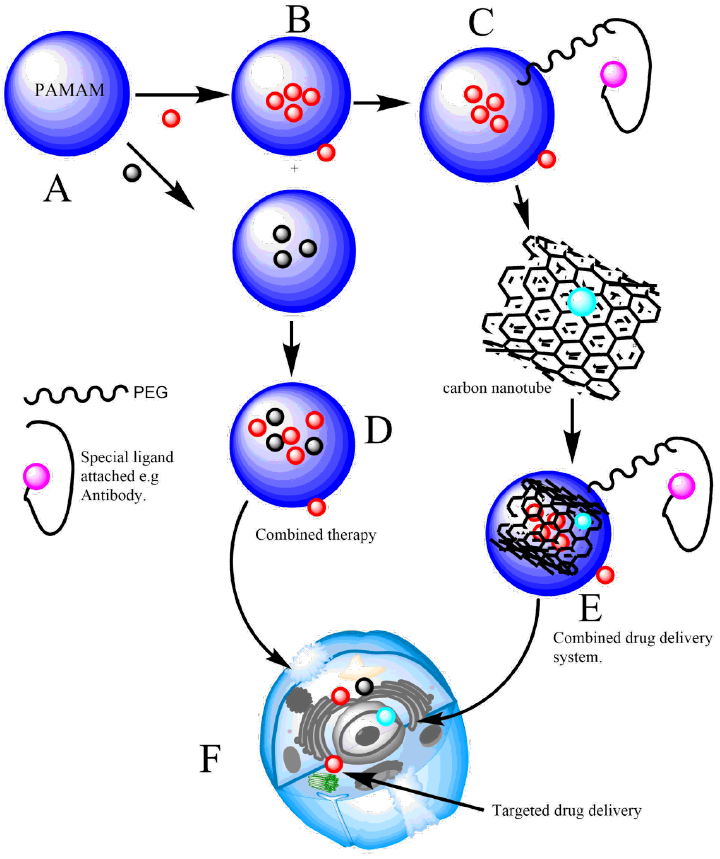
Figure 1. A scheme representing two systems which is promising in improving the solubility of poorly water soluble molecules. B , D show a combined therapy drug delivery system for improved solubility, in such a system, two different drugs are loaded into the dendrimer separately, then the two nanosystems are combined together to have one system with two different drugs. The two drugs are both delivered to cell F . C , E represent a combined drug delivery system, in such a system, two different nanoparticles are prepared separately loaded or unloaded with drugs. Then, the two systems are combined together and drug is released. Conjugation with polyethylene glycol PEG and/or special ligands such as antibody to polyamidoamine (PAMAM) dendrimer nanohybrid not only improves solubility and sustains release of drugs but also enhances targeted drug delivery. Red, black, and blue balls represent drugs entrapped or conjugated into the nanohybrid